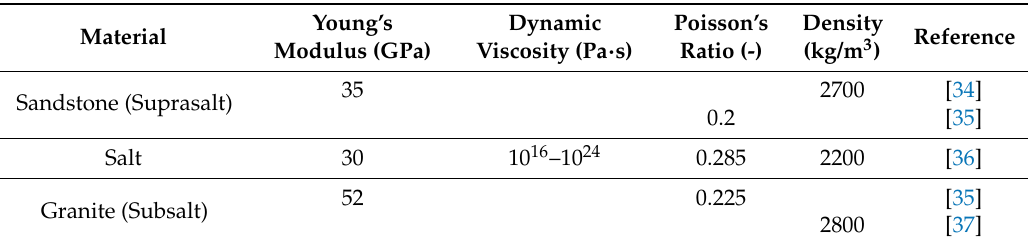
Table 2. Assigned Material